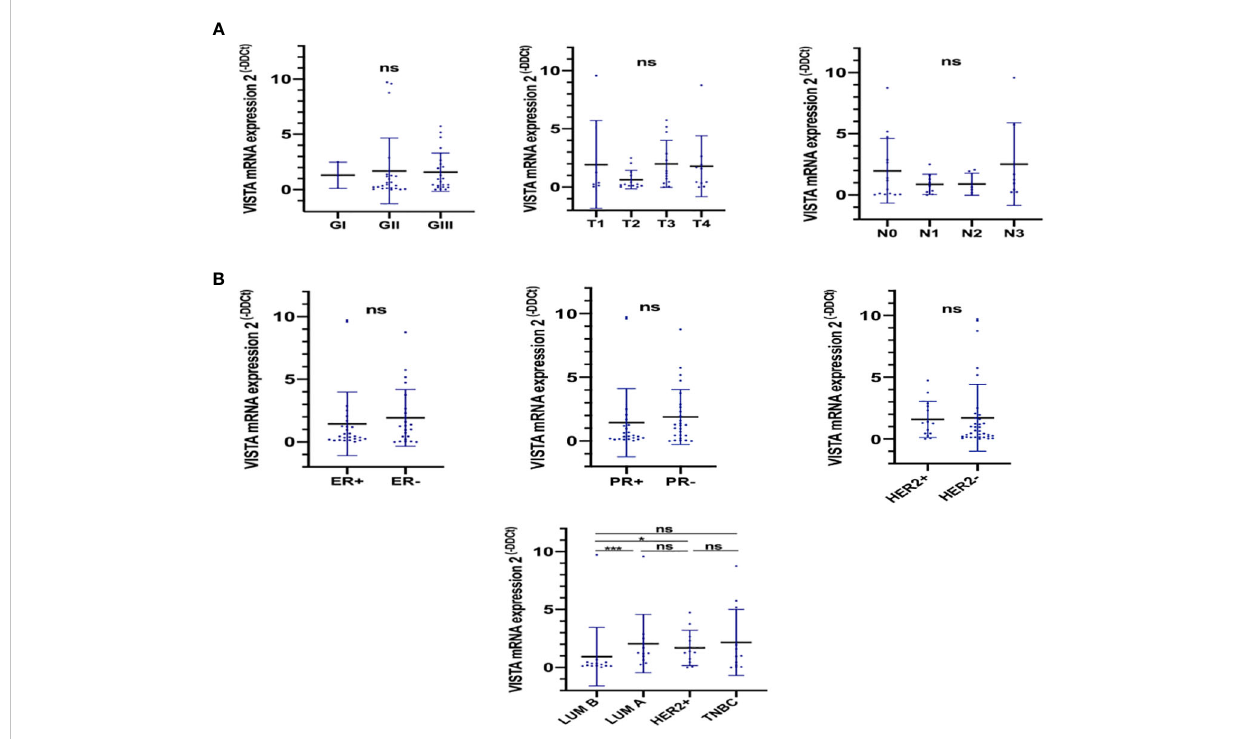
FIGURE 2 VISTA expression according to different parameters of breast cancer. RT-PCR assays were performed to evaluate VISTA expression. (A) VISTA expression according to the tumor grade, tumor size, and lymph node status. (B) VISTA expression according to ER, PR, HER2 status and breast cancer molecular subtypes. *Indicates p-value < 0.05, ***Indicates p-value < 0.001. ns Indicates test non signi fi